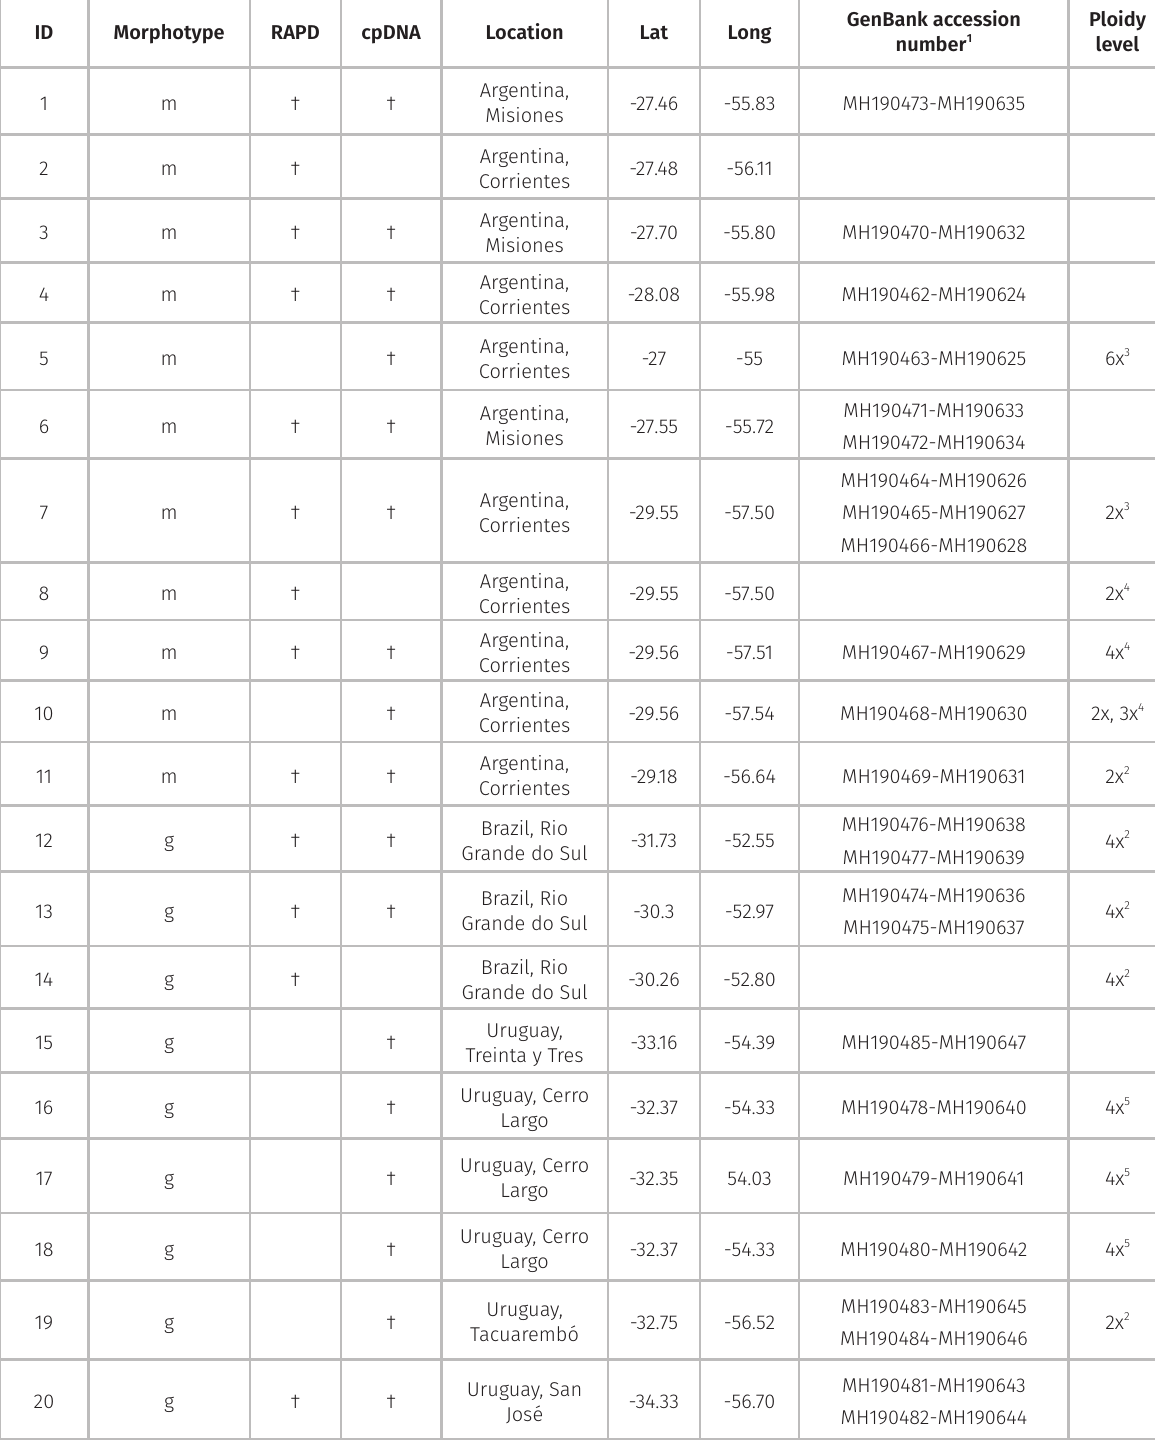
Table I. Populations of Turnera sidoides subsp. carnea analyzed with molecular markers. ID= population identity, g= grandense ; m= mercedeño . 1 EMBL GenBank accession numbers for cpDNA intergenic spacer sequences. 2 New ploidy level estimations. 3 Speranza et al. (2007). 4 Kovalsky et al. (2017). 5 Solís Neffa & Fernández